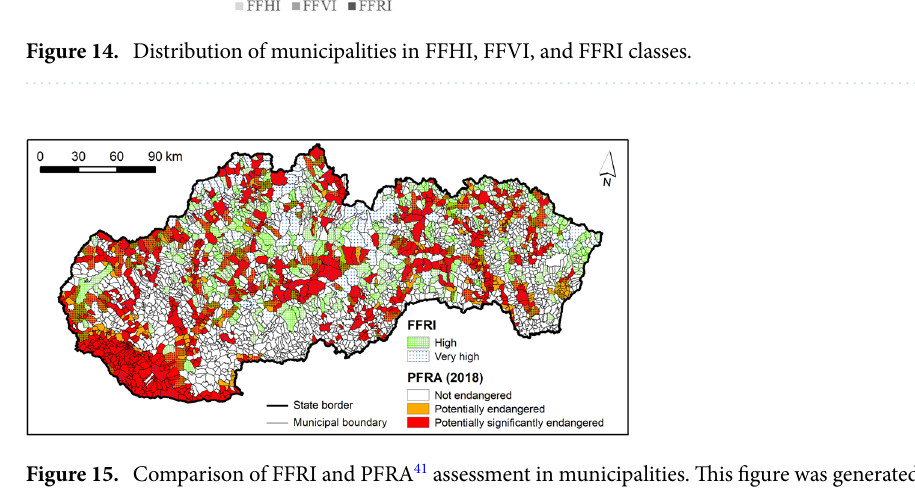
Figure 15. Comparison of FFRI and PFRA 41 assessment in municipalities. This figure was generated in ArcGIS 10.2.2